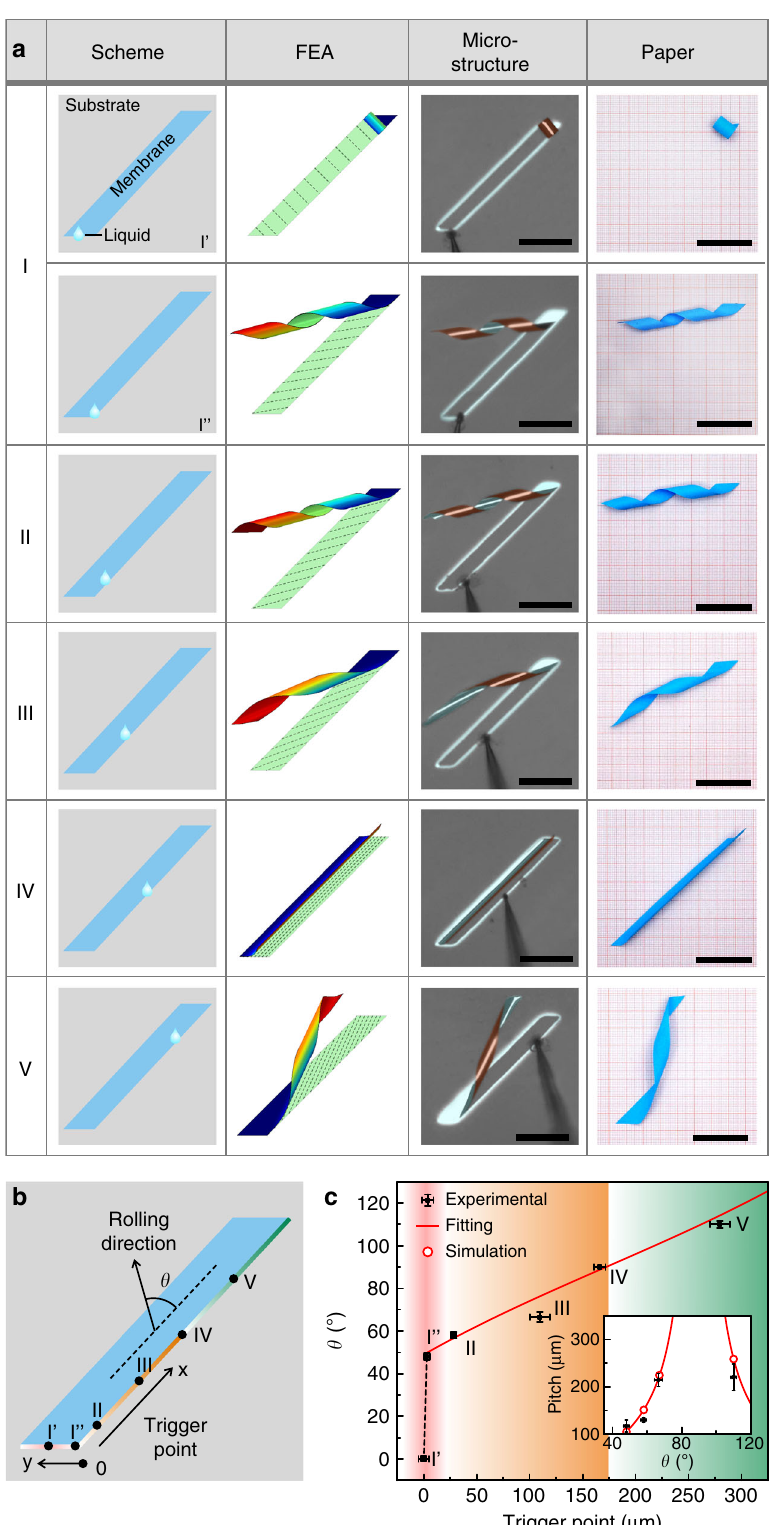
Fig. 3 Precise control in rolling direction towards helical microstructure construction. a The scheme of parallelogram-patterned nanomembrane with different microdroplet trigger point (I – V), FEM predictions, experimental results (optical images), and corresponding paper works (photographs) of six different microstructures. Dashed lines in the FEM model elucidate the sketch of partition in the quasi-static model. Scale bar (third column), 100 μ m. Scale bar (forth column), 3 cm. b Schematic illustration of the de fi nition of rolling angle θ and trigger point in parallelogram-patterned nanomembrane. Colorized edges depict different rolling behavior starting from the right bottom corner (orange) and right top corner (green). c Relation between rolling angle θ and trigger point. The diagram is divided into three regions according to different rolling behavior in a . The inset plots the relation between helical pitch and rolling direction. Error bars represent standard